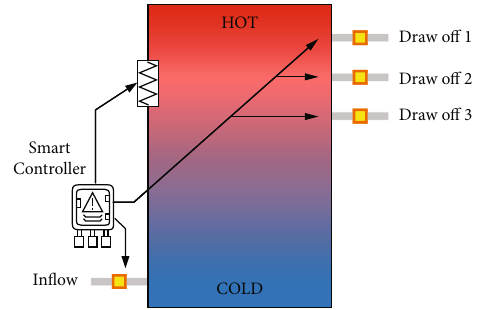
Figure 4: Smart thermal storage tank with auxiliary